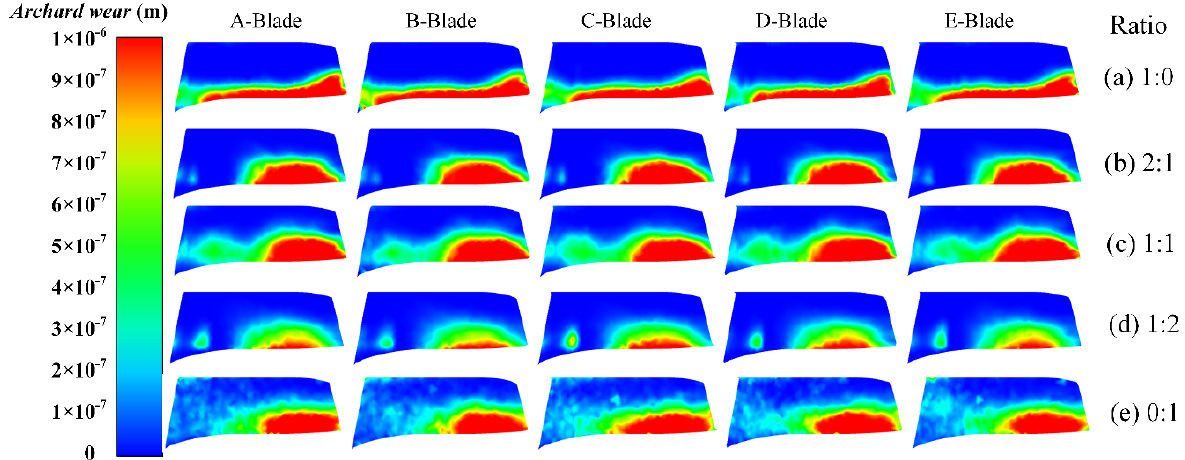
Figure 14. Blade pressure surface wear distribution under different particle ratios.